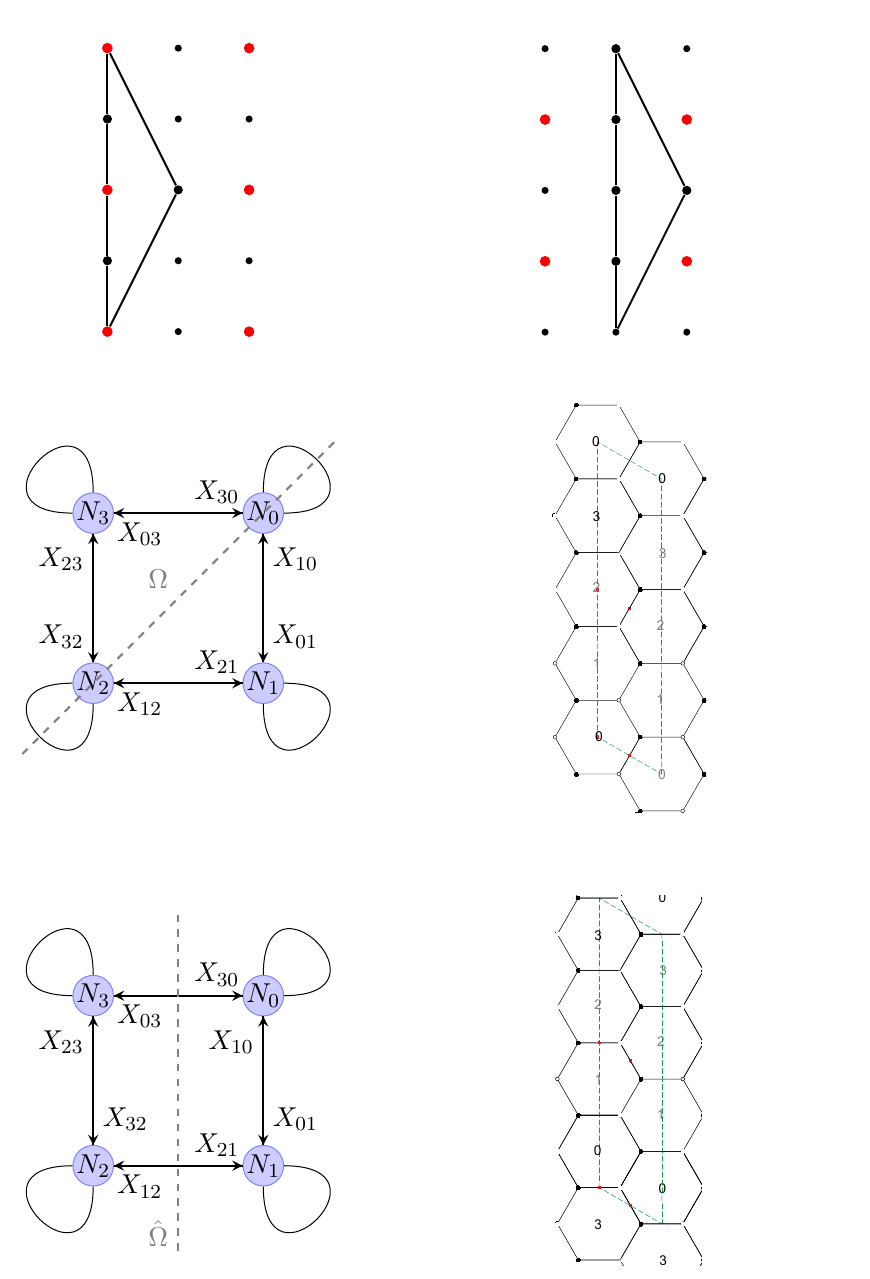
Figure 31. The various unoriented descriptions of C 3 = Z 0 diagram and the toric involution with a non-compact (cid:10)7 (left) and a (cid:10)3 (right). The middle row shows the orientifold involution (cid:10), on quiver (left) and dimer (right), while in the lower row are drawn the quiver (left) and the dimer (right) for the ^(cid:10).